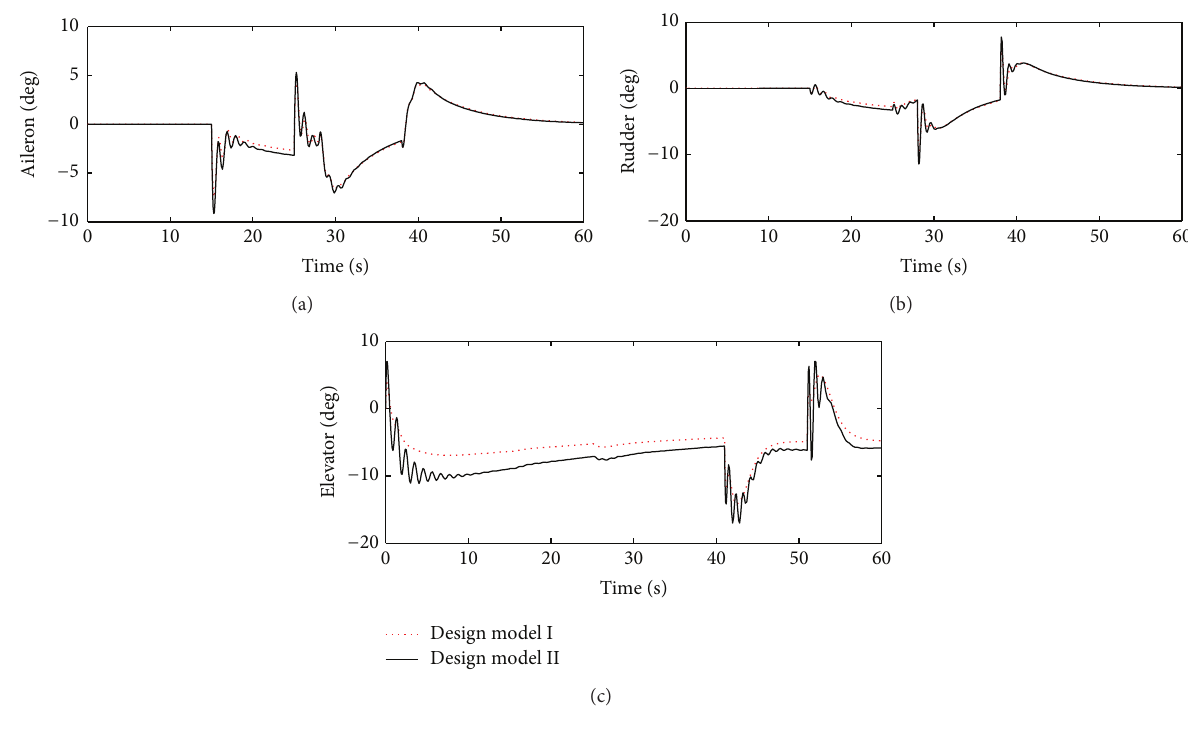
Figure 8: Deflections of the control actuators in two design models.